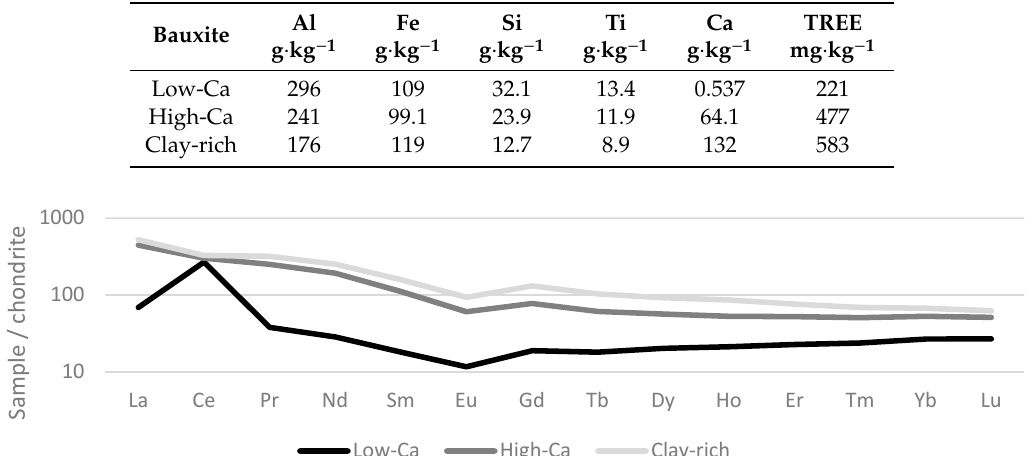
Table 4. Major element and total REE (TREE) composition of bauxites used in this study.